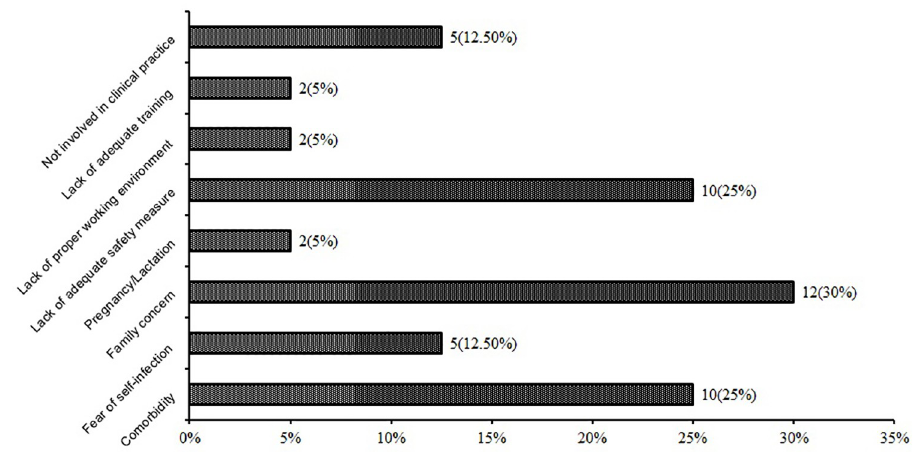
Fig 2. Barriers of willingness to work during pandemic (n =